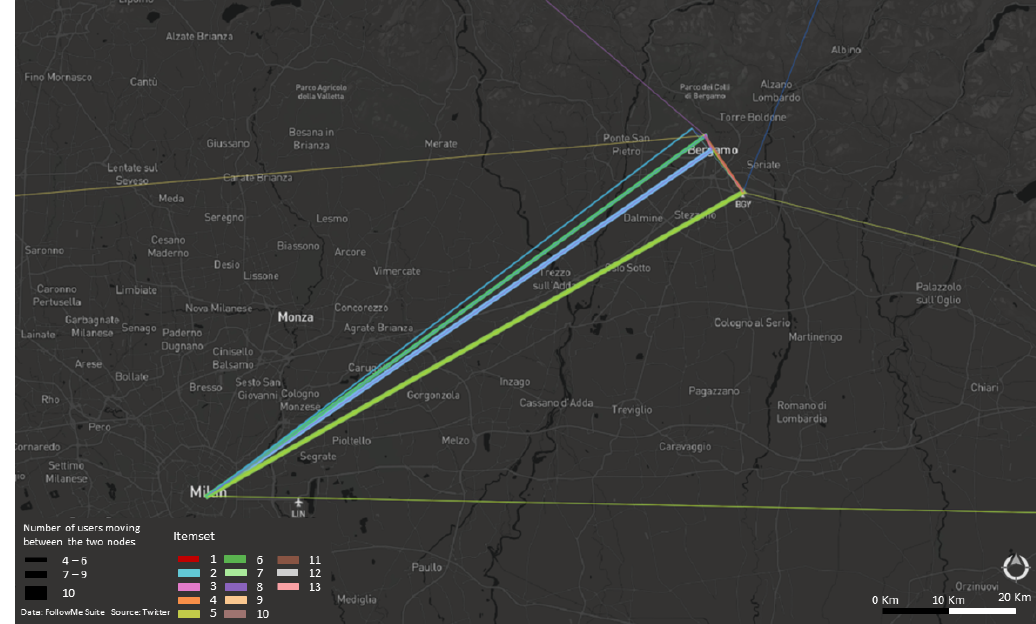
Figure 2. Topographic representation for discovered itemsets associating places (Interpretation 1), focused at the level of surrounding regional territory of